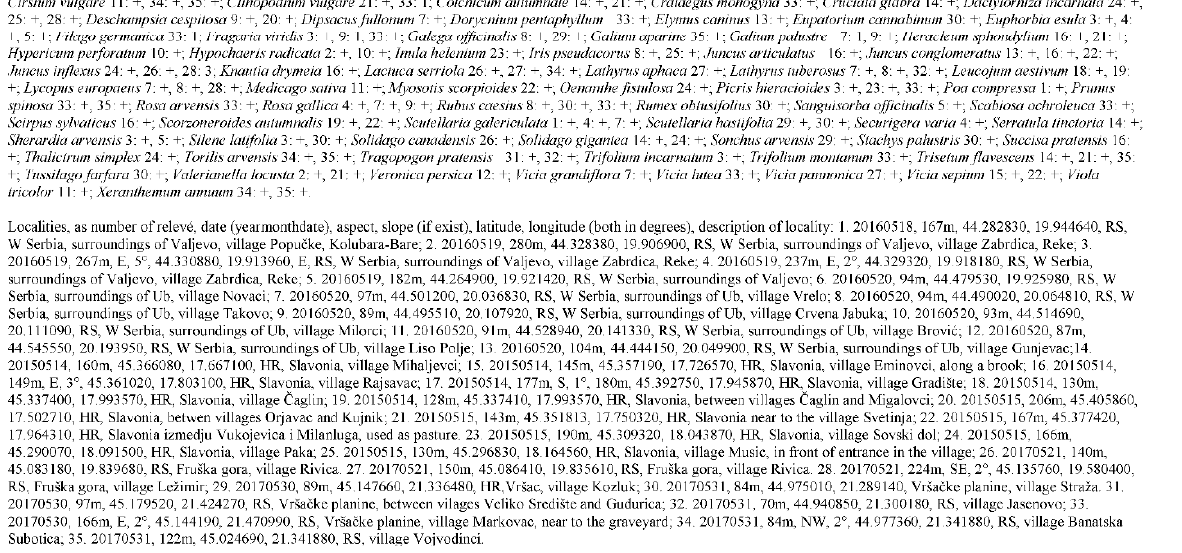
Figure A2. Analytic table of the new field data used in the analysis. The relev é s are classified in accordance with Figure A3, diagnostic species of the associations are framed. The following associations were sampled: 1–13 Trifolio pallidi–Alopecuretum pratensis , 14–32 Ranunculo strigulosi–Alopecuretum pratensis , and 33–35 Ornithogalo pyramidale–Trifolietum pallidi .